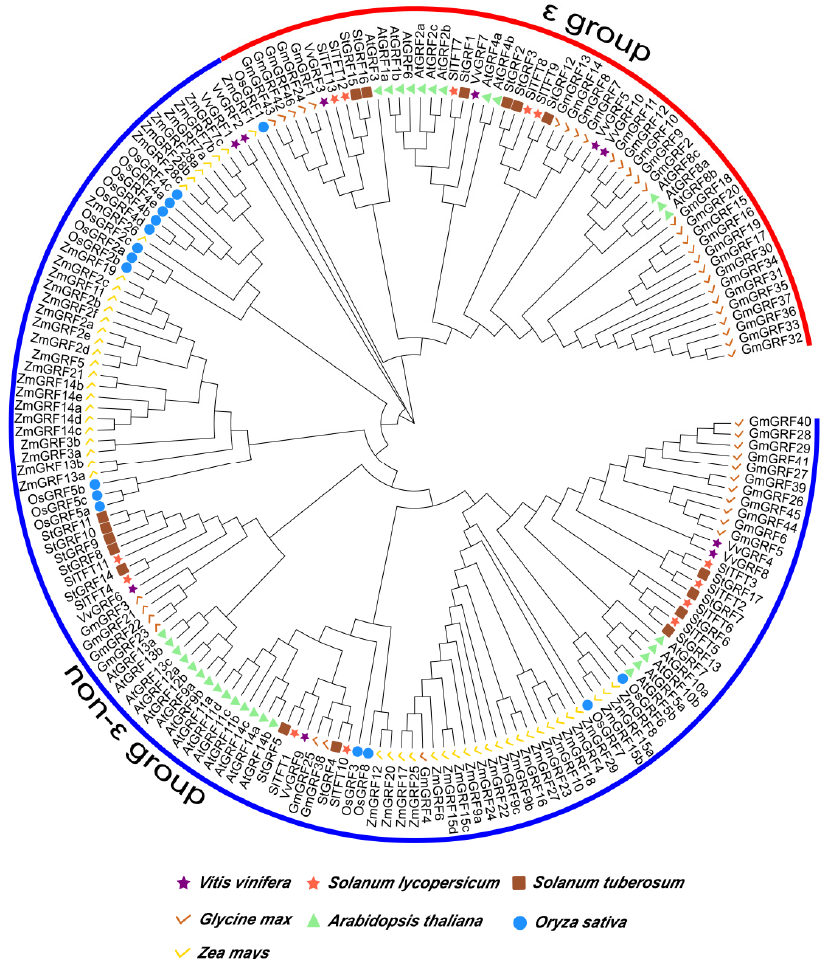
Figure 3. Phylogenetic analysis among SlTFTs and six other species. All 170 14-3-3s were compared in multiple sequences and a phylogenetic tree was constructed using the maximum likelihood method and 1000 bootstrap resamples in MEGA 11 software. The different color shapes represent the 14-3-3s in different species. Red and blue colors in the outer circle represent different groups, respectively.